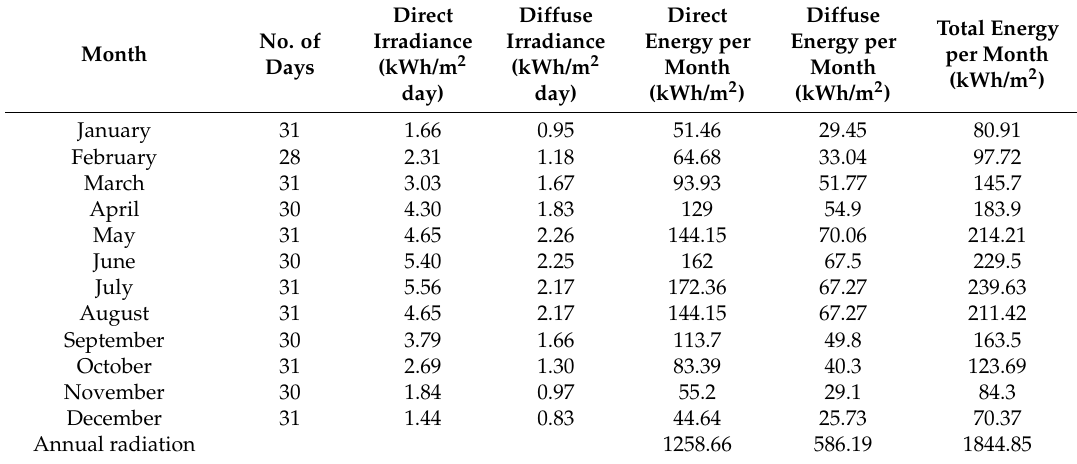
Table 9. The received solar energy per day, month, and year.